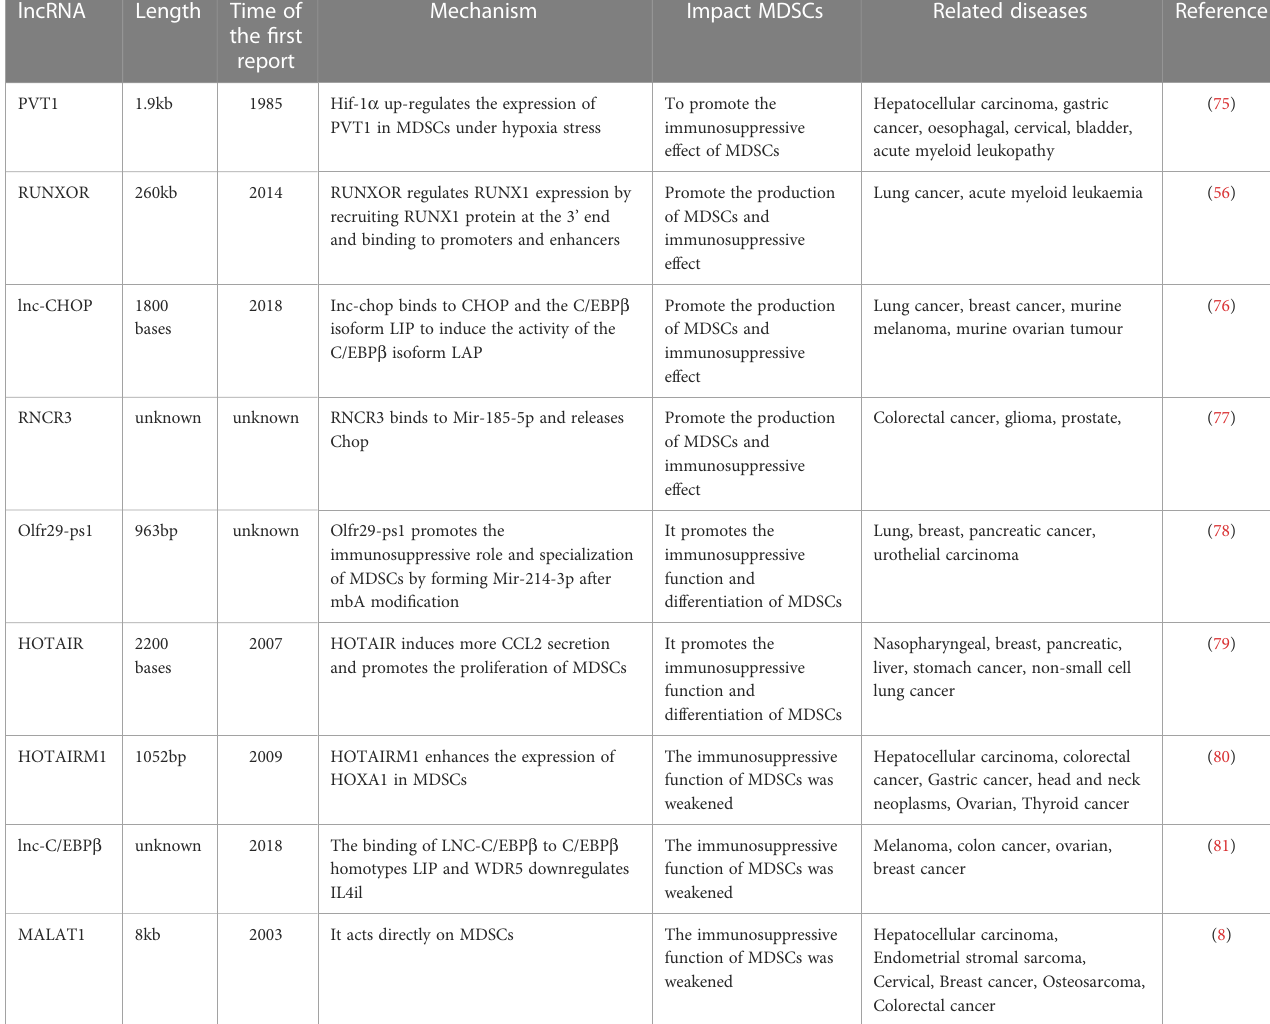
TABLE 2 Expression of lncRNA and its regulatory effect on